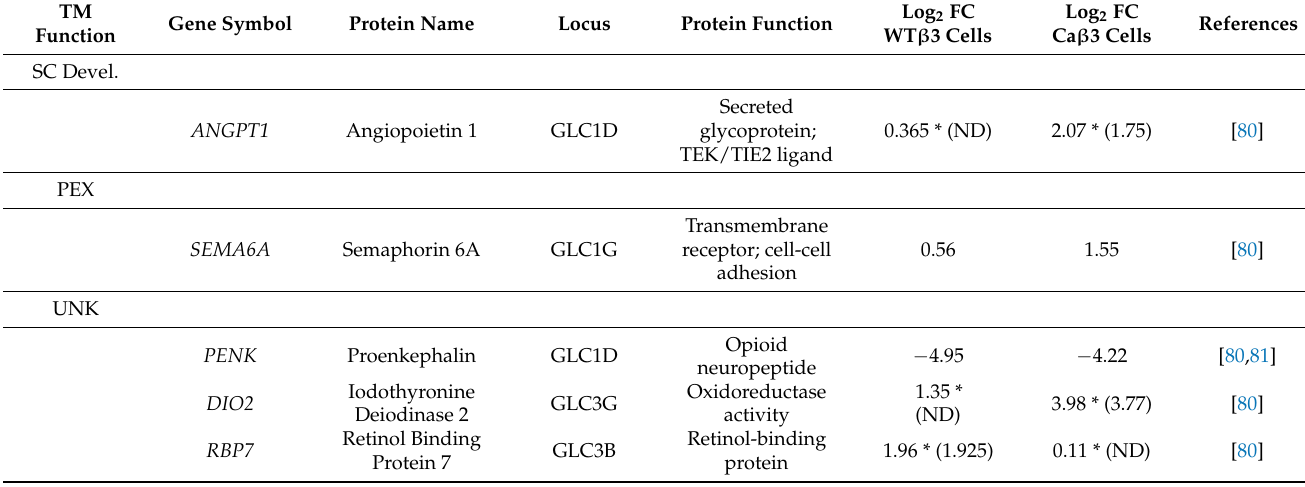
Figure 6. Hierarchical clustering of adhesion-associated genes finds differential gene expression in WT β 3 and CA β 3 cells relative to EV control cells and to each other. Genes from each of the three contrasts analyzed for DGE that met the Log 2 FC ± 1.5 cutoff and were classified as encoding either adhesion proteins or adhesion-associated proteins were analyzed as in Figure 4. A heat map displaying standardized z-scores was generated. The clusters identified by letters on the right side of the map were determined manually. Genes within each of these clusters are listed in the displayed table. Those genes highlighted by an asterisk represent genes that had been dealt with as described for Figure 4. Table 4. Differentially expressed genes in WT β 3 and/or CA β 3 cells that are located on a glaucoma locus. Except where noted by *, Log 2 FC values were reported in DGE analysis using EdgeR. * Genes that were filtered out due to low abundance did not originally have a FC determined (ND). Log 2 FC was calculated from the raw count data. The values in parentheses were originally calculated using